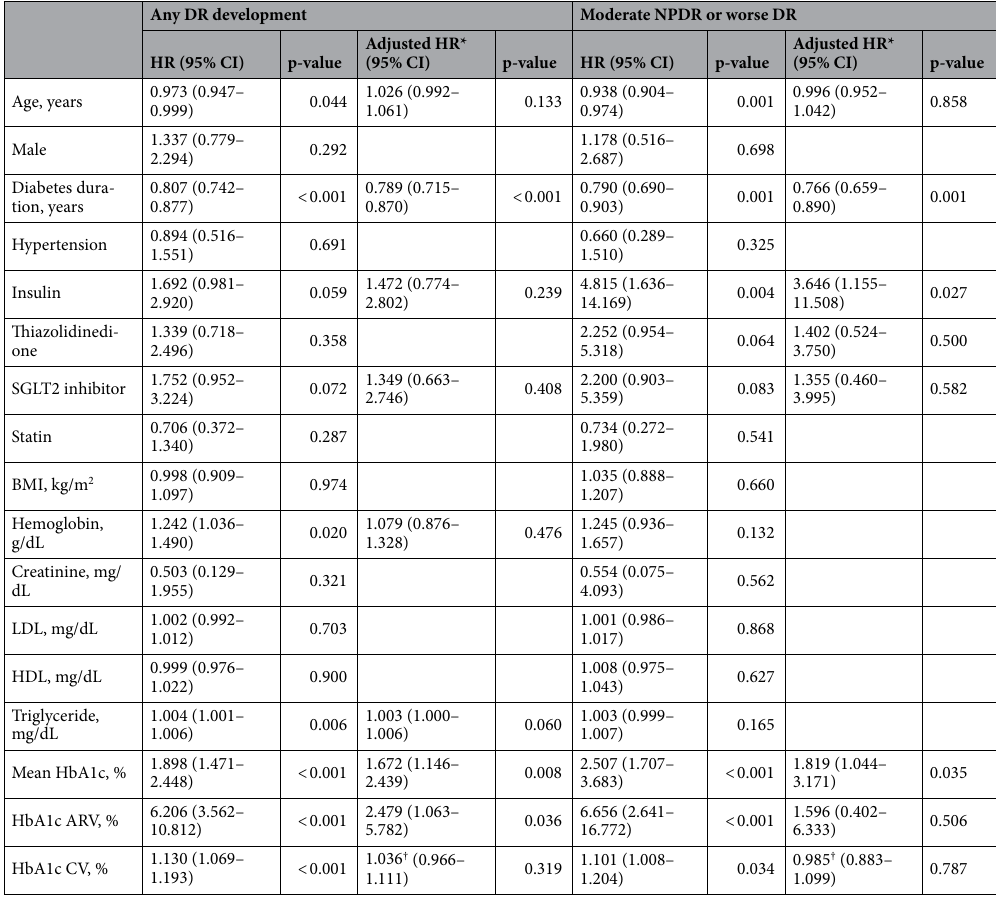
Table 3. Cox proportional hazards regression analysis for factors associated with development and progression of diabetic retinopathy. *Adjusted hazard ratio (HR) was calculated from multivariate analysis using variables with p < 0.100 in univariate analysis. For those HbA1c variability indexes (HbA1c ARV and HbA1c CV), only HbA1c ARV was entered into the equation. † Adjusted hazard ratio for HbA1c CV was